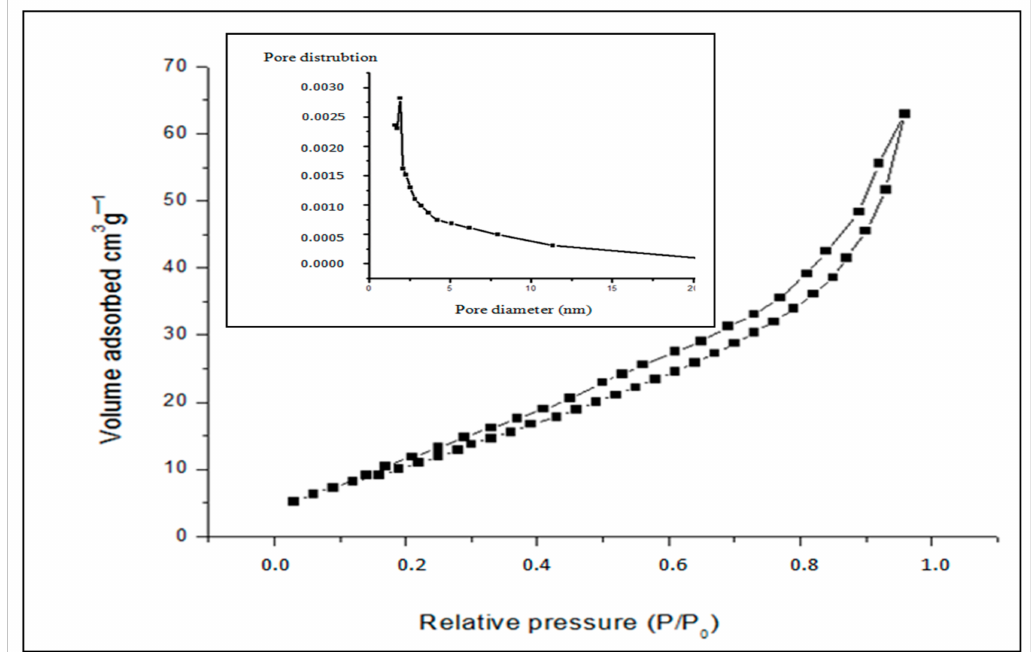
Figure 3. N 2 Adsorption/desorption isotherm of natural iron oxide.